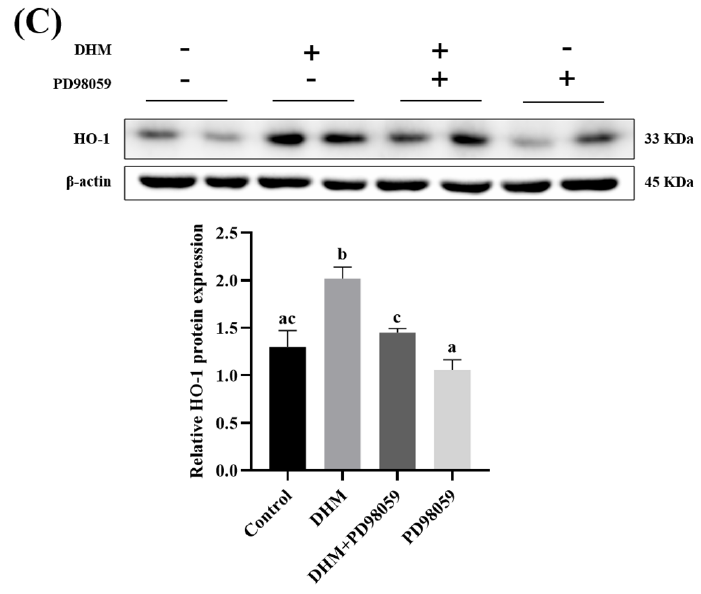
Figure 4. Effect of ERK inhibitor PD98059 on antioxidant-related protein expressions in IPEC-J2 cells. The IPEC-J2 cells were treated with DHM (20 µ mol/mL) and PD98059 (10 µ mol/mL) for 36 h. ( A ) The protein level of p-ERK. ( B ) The protein level of nuclear Nrf2. ( C ) The protein level of HO-1. Data are expressed as the mean ± SE. Values with different superscript letters are significantly different ( p < 0.05).